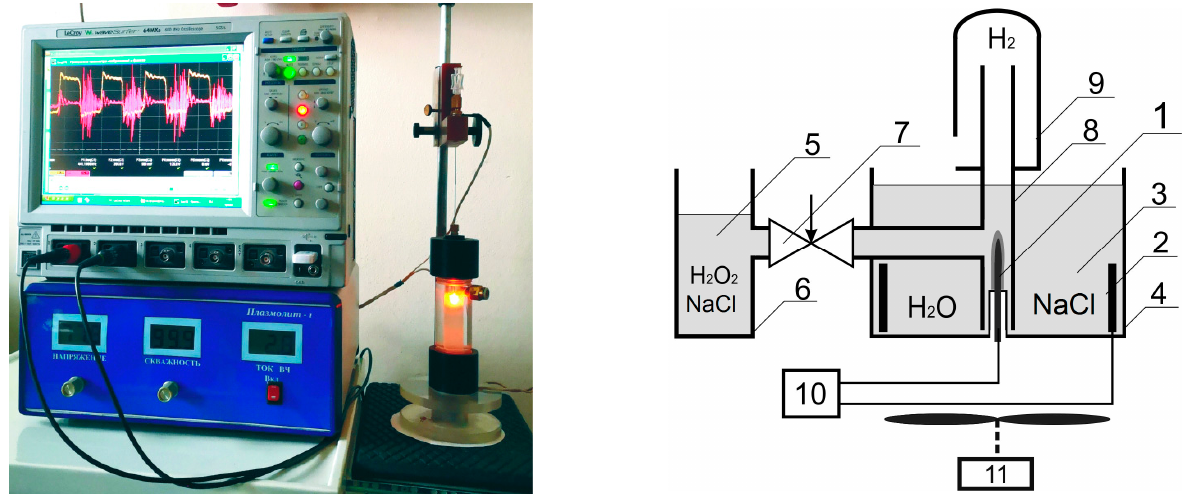
Figure 5. Photographs and schematic diagram of a reactor for obtaining an activated solution. Active electrode—1, neutral electrode—2, electrolyte solution—3, container for electrolyte—4, activated solution—5, container for activated Scheme—6. adjustable leak—7, quartz tube for overflow of activated solution—8, container for collecting hydrogen—9, high-frequency generator—10, magnetic stirrer—11.